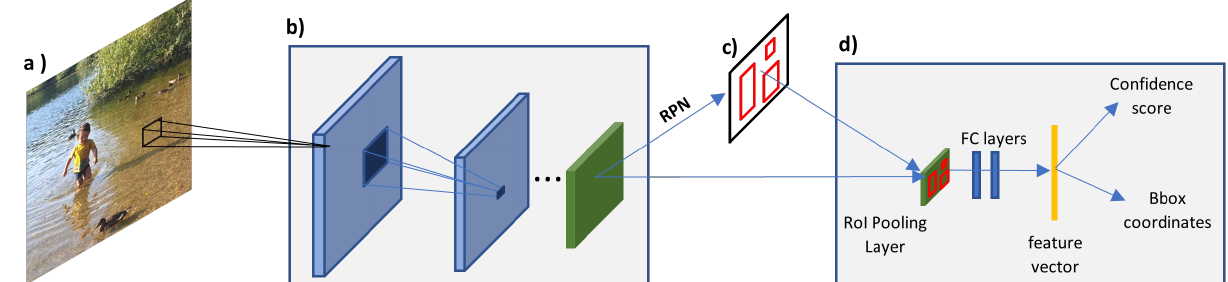
Figure 10. Faster R-CNN architecture: ( a ) Input image. ( b ) CNN is used to generate feature maps of the entire input image only once. ( c ) RoIs are acquired using Region Proposal Network (RPN). ( d ) The RoI is projected onto the generated feature map of the whole image. Then, pooling and fully connected layers are applied onto the feature map with the projected RoI to generate a feature vector. The feature vector is used by softmax, and bbox regressor to output confidence score and bbox coordinates [67].